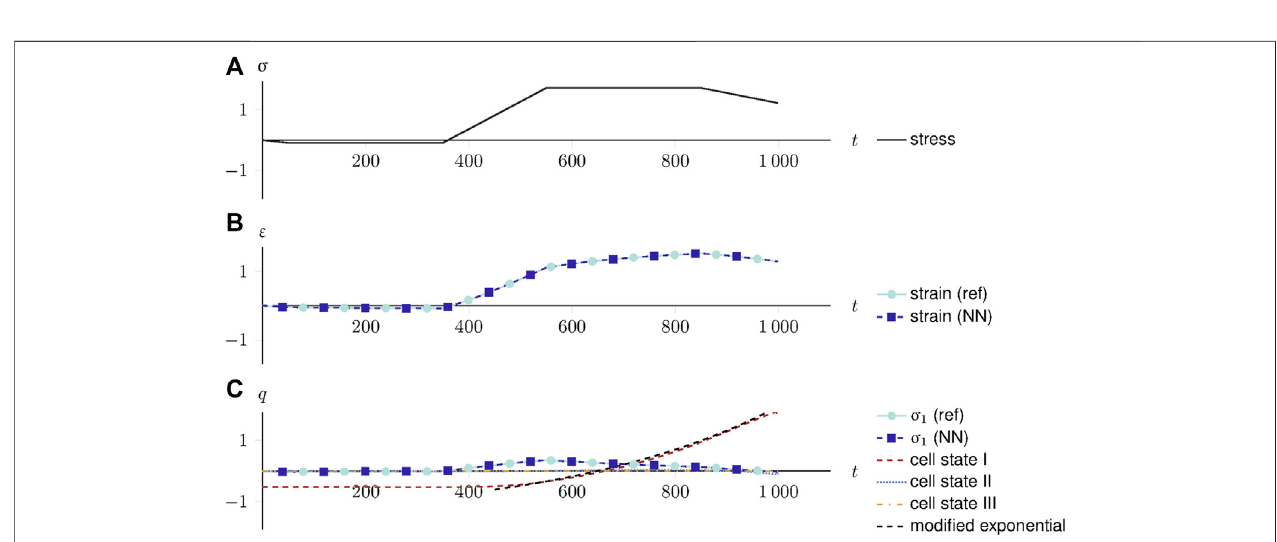
FIGURE 12 | An explainable viscoelastic constitutive model. (A) The stress-driven loading over time. (B) The strain response of the reference and data-driven constitutive model. (C) The branch history stress compared to the three major principal components of the cell state. Instead of mimicking the history variables used to generatetrainingdata,thecellstateslearnedagenericsolutionforviscoelasticity:amodi fi edexponentialfunctionthatcanbeshiftedandscaledatwillbytheoutputlayer.